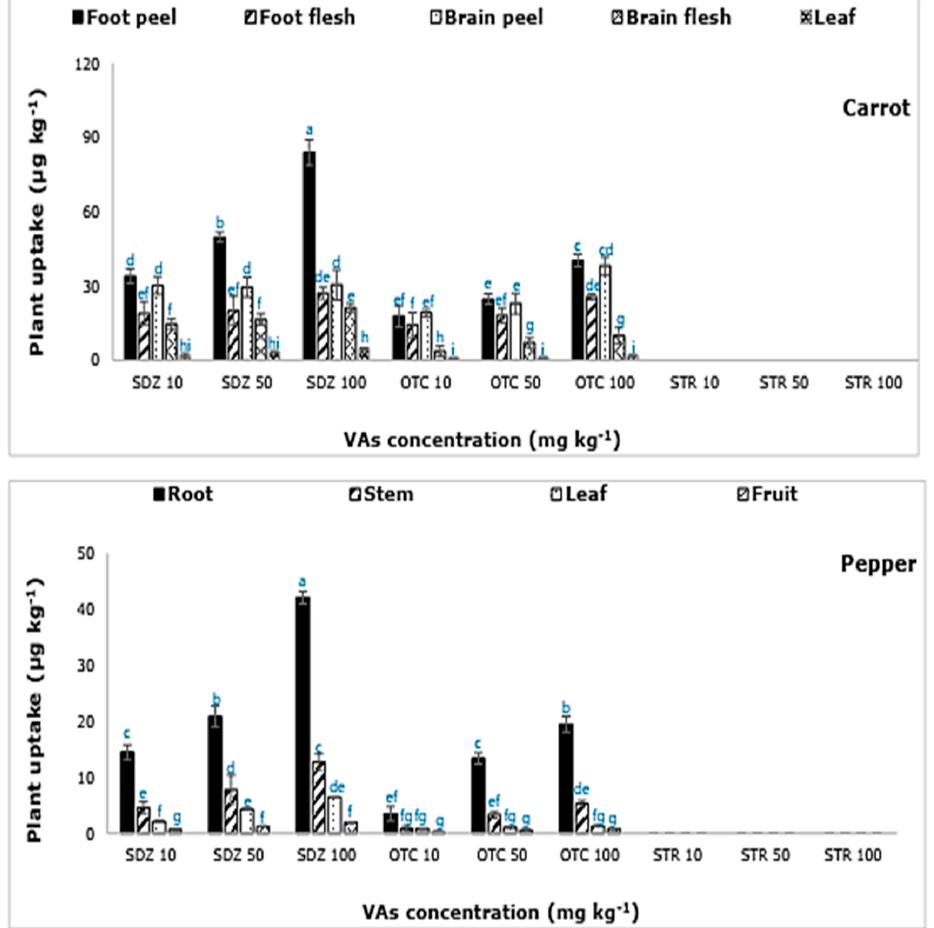
Figure 1. Uptake of veterinary antibiotics (VAs) by different parts of lettuce, carrot, and pepper grown in soil treated with VAs. Error bars represent standard error. Concentration values followed by different letters are significantly different ( p < 0.05) according to Duncan’s multiple range test. SDZ